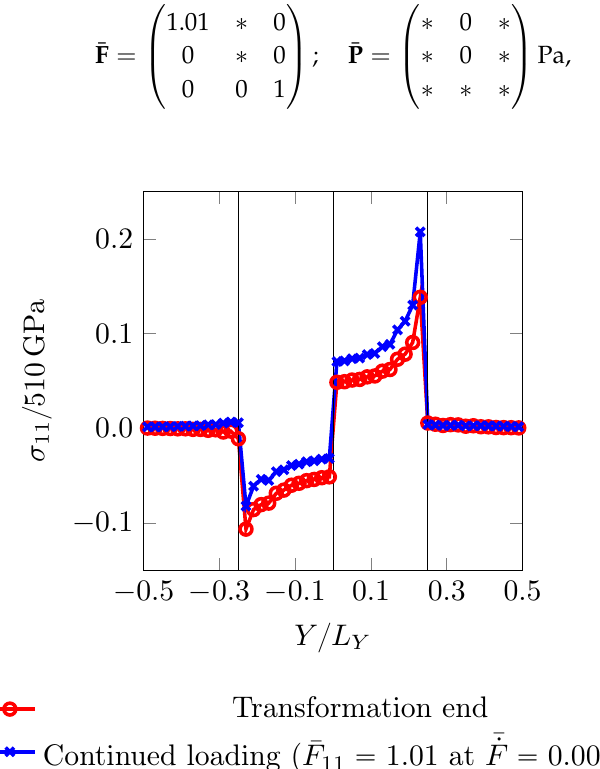
Figure 16. σ 11 profile along the path X = L X /100. Normalization is done by the elastic constant c 11 . κ = κ 2 is